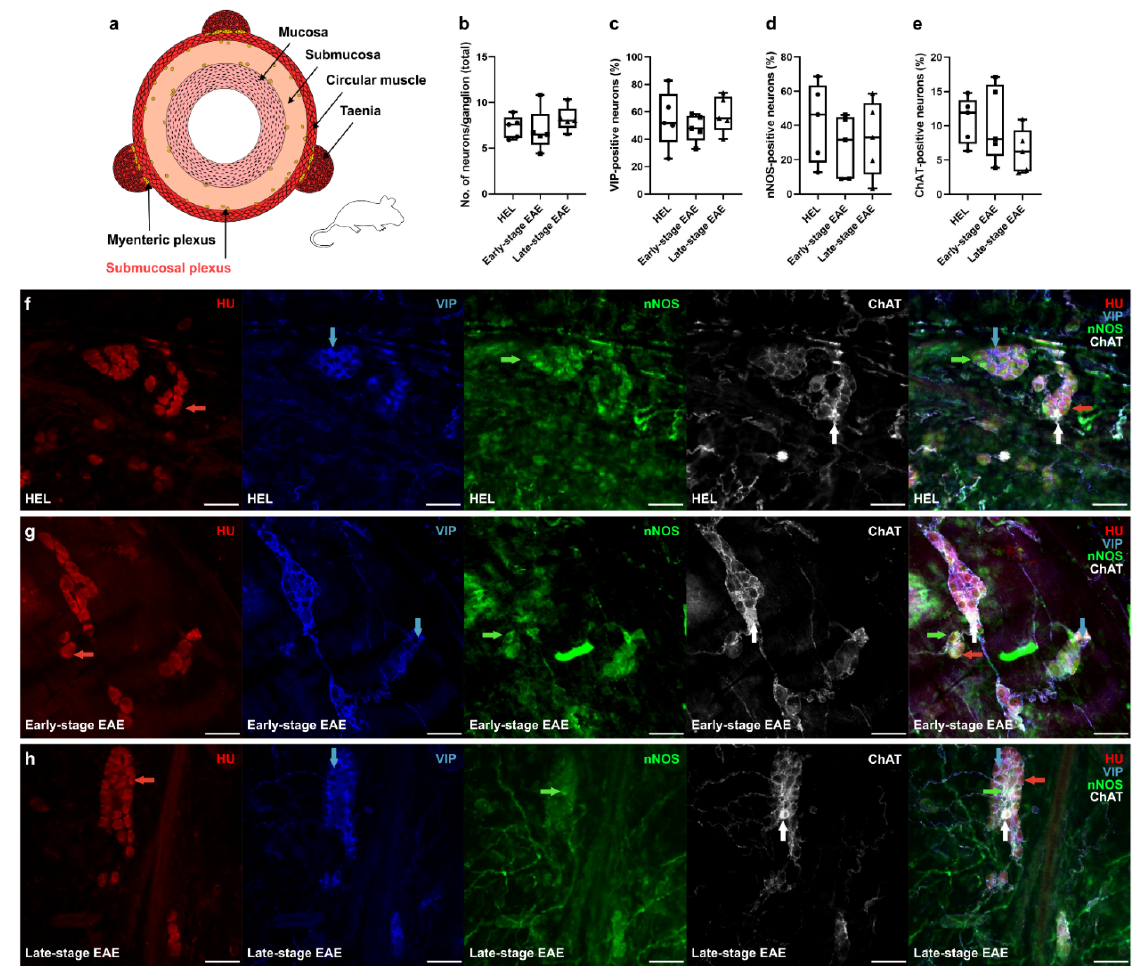
Figure 1. Immunohistological staining of murine submucosal plexus (SP). ( a ) Whole mounts were obtained from the colons of female C57BL/6J mice with early-stage experimental autoimmune encephalomyelitis (EAE) ( n = 5), late-stage EAE ( n = 5), or after immunization with the control antigen hen egg lysozyme (HEL) ( n = 5). ( b ) Numbers of neurons per ganglion analyzed in each group. ( c – e ) Percentage of ( c ) vasoactive intestinal peptide (VIP) + , ( d ) neuronal nitric oxide synthase (nNOS) + , and ( e ) choline acetyltransferase (ChAT) + neurons in relation to the total number of HuC/D (HU) + neurons in each group. Individual data points display mean values per mouse. The box and whisker plots show median values, together with the interquartile range. For normally distributed data, statistical significance was determined by one-way analysis of variance; otherwise, a Kruskal–Wallis test was applied. ( f – h ) Representative single-optical sections from z-stacks (z-steps: 1.0 µm) of quadruple staining for HU ( red arrow , first column), VIP ( blue arrow , second column), nNOS ( green arrow , third column), ChAT ( white arrow , fourth column) and the combination of all four (fifth column) in ( f ) HEL-immunized, ( g ) early-stage EAE, and ( h ) late-stage EAE mice. Scale bars denote 50 µ